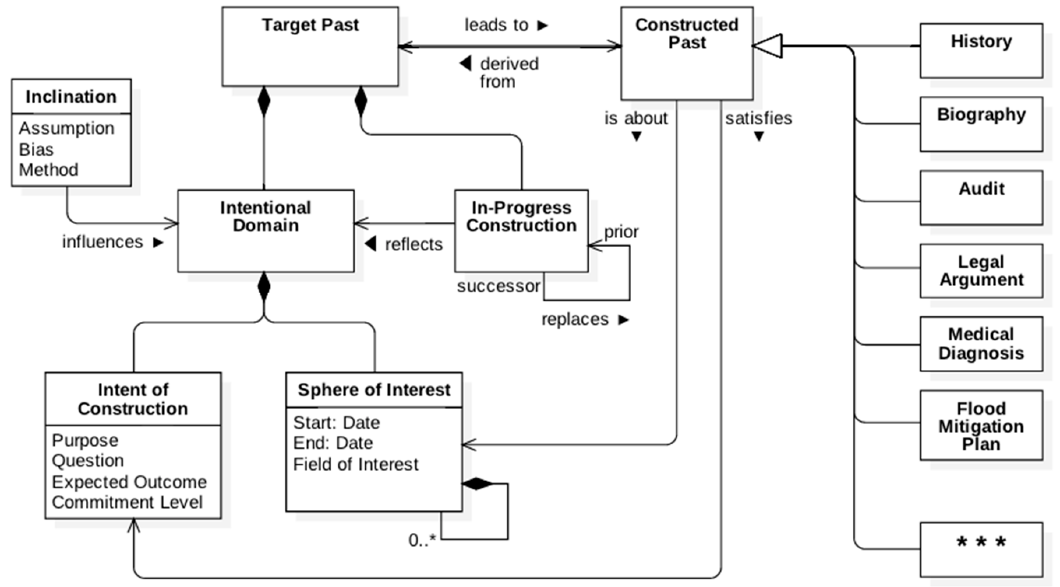
Figure 1. Framework for Construction of the Past. The construction of the past centers on the Target Past, which comprises both an Intentional Domain that specifies what is being attempted and why and an In-Progress Construction, which is the state of construction during the process. The final output is a Constructed Past.